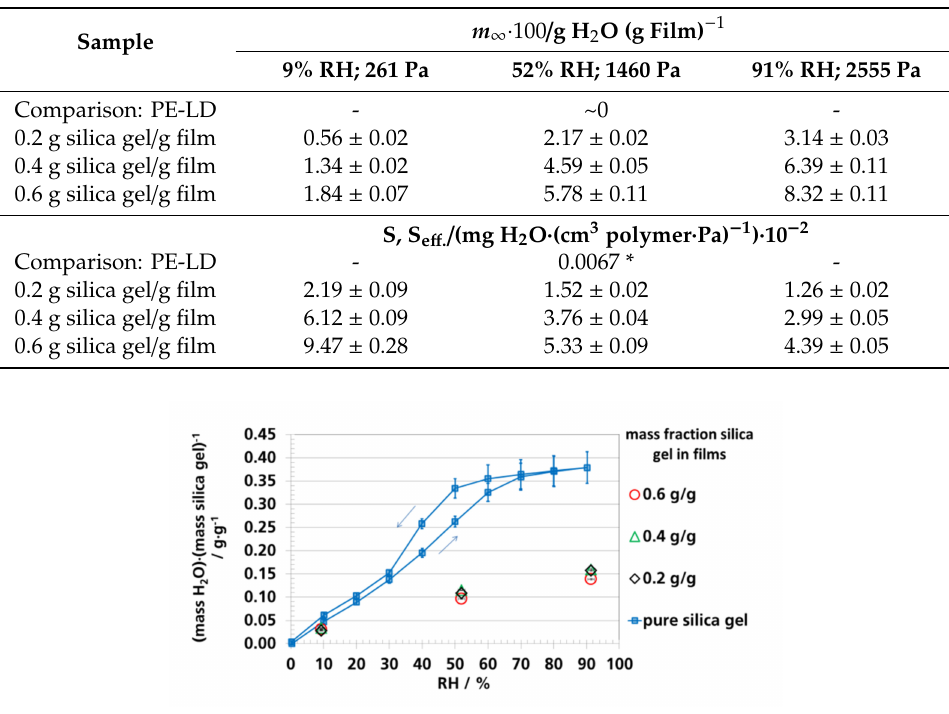
Table 4. Water vapor absorption capacity ( m ∞ ) of films; calculated sorption coe ffi cient S e ff . (Equation (4)); at 23 ◦ C; * sorption coe ffi cient from published value [91].